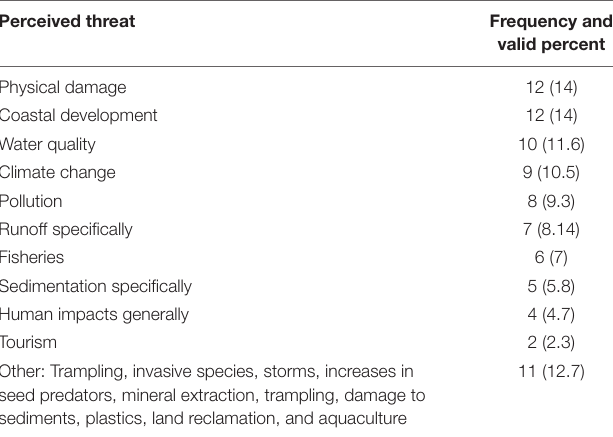
TABLE 11 | Perceived threats to seagrass ecosystems by current users of seagrass citizen science projects.